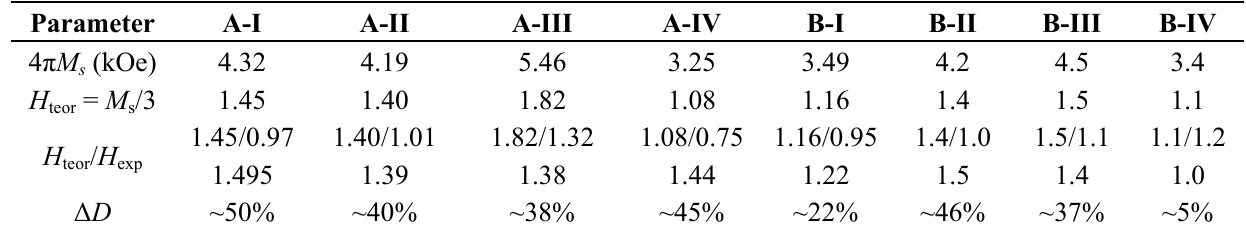
Table 2. Selected results of magnetic measurements: M H -coercivity Δ D -deviation from the position for spherical C